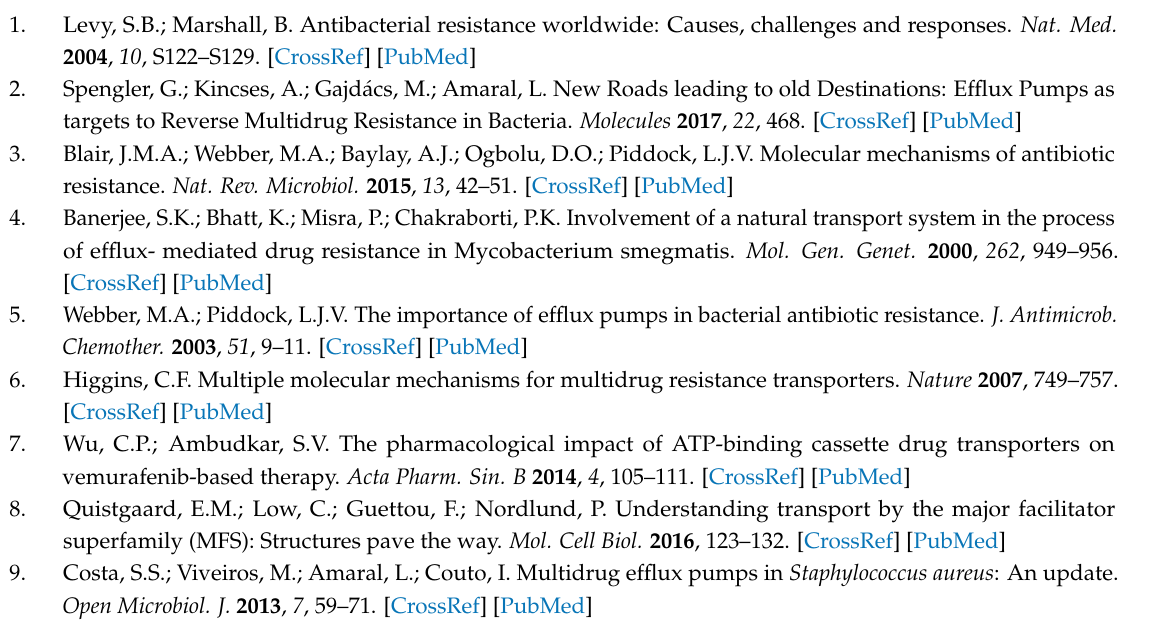
Figure S1: Pairwise alignment of NorA and EmrD MFS transporter proteins, Figure S2: Quality of the NorA model, Figure S3: Location of binding sites of NorA model, Table S1: Hydropathy analysis of Quinolone resistance protein NorA from S. aureus and EmrD from E. coli , Table S2: Conserved residues for EmrD and NorA efflux pump proteins, and Table S3: The 20 best lead compounds obtained by